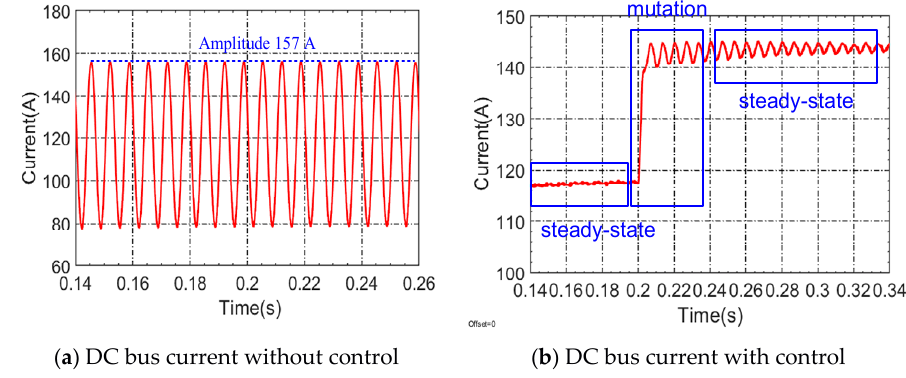
Figure 6. DC-bus current fluctuation comparison in three-phase charging mode. At this time, another different group of MCMs is put into operation. When the output current amplitude I out − 6 is 45 A (random), the DC bus current amplitude is 34.81 A. Only one of the parameters and the phase of group 5 voltage need to be changed through algorithm analysis. The DC-bus current phase δ 5 and δ 6 are 2.2896 and 0.3343 by the algorithm, respectively. Additionally, the output voltage phase θ 5 and θ 6 are 0.7890 and 0.1552, respectively. Comparing DC bus current fluctuation is shown in Figure 6b, which shows that the proposed algorithm can effectively reduce the bus current fluctuation.